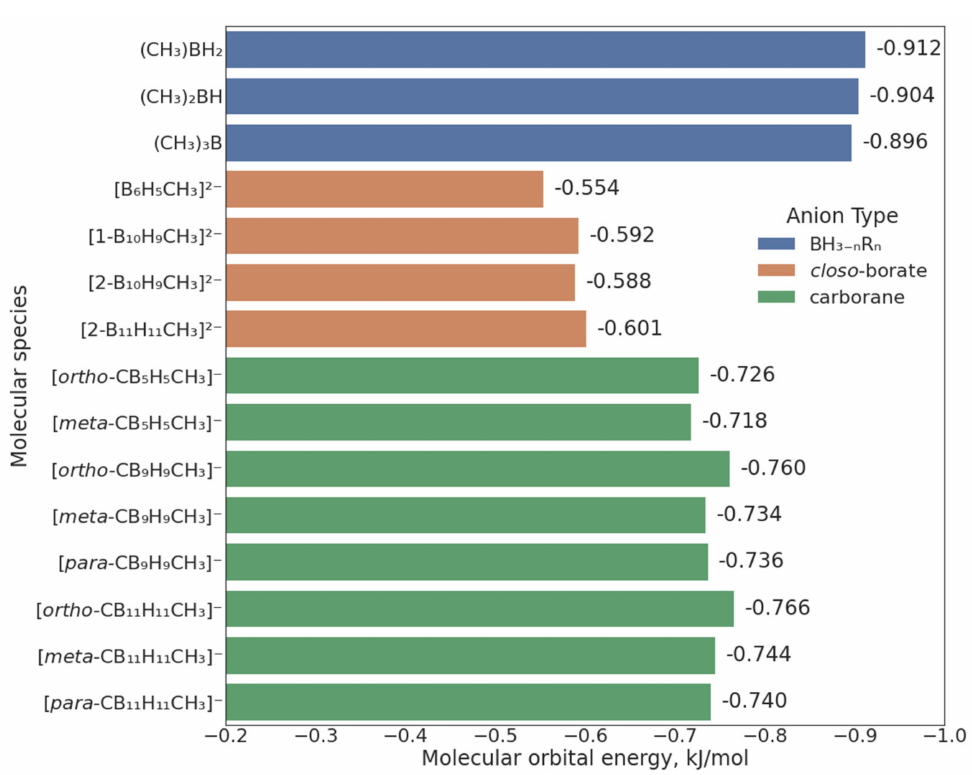
Figure 5. Values of B–C molecular orbital energies in closo-borate anions of the general form [B n H n − 1 CH 3 ] 2 − (n = 6, 10, 12), monocarboranes [CB n H n CH 3 ] − (n = 5, 9, 11) and BH 3 − n (CH 3 )